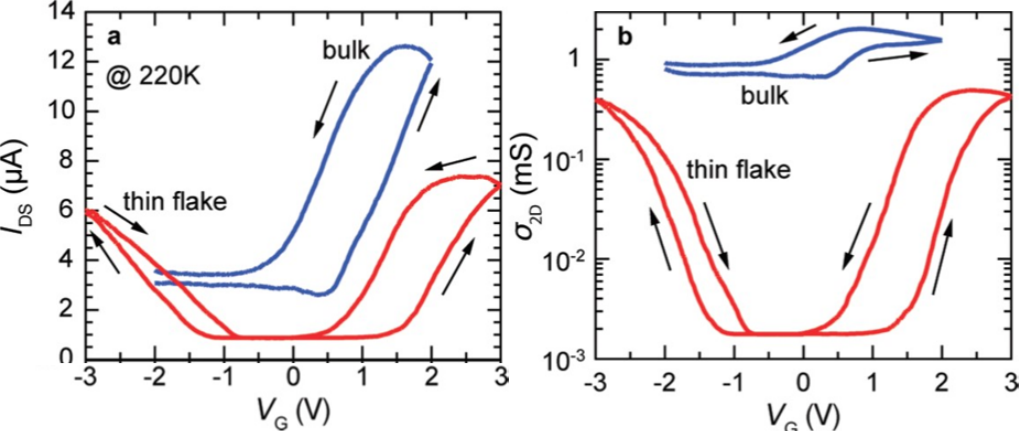
Figure 8. Transfer curve of bulk (1000 μ m × 500 μ m × 10 μ m) and thin ‐ flake (20 μ m × 20 μ m × 15 nm) MoS 2 EDLTs. ( a ) Change in the channel current (I DS ) as a function of gate voltage (V G ). ( b ) Change of sheet conductivity ( σ 2D ) as a function of gate voltage (V G ). Channel voltage (V DS ) is 0.2 V for both devices. Reproduced with permission from [150], American Chemical Society, 2012.